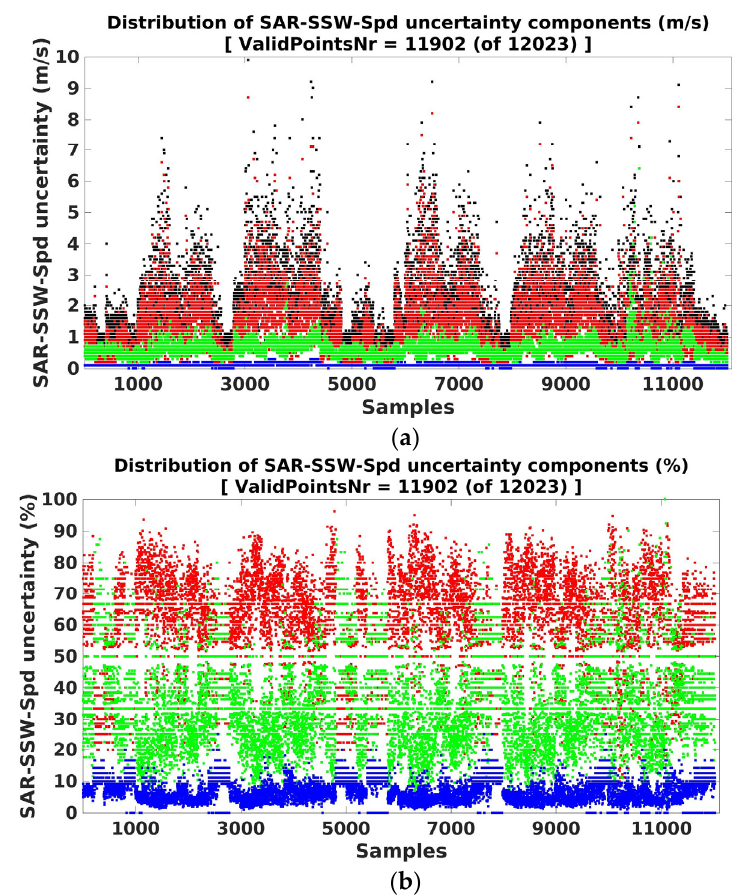
Figure 5. The total CMOD5.N-derived SAR SSW speed uncertainty ∆ W max (m/s) (purple), derived considering the three uncertainties ( ∆ σ 0 , ∆ θ , ∆ ϕ ) and the true state ( σ 0 , θ , ϕ ), and the contribution to this uncertainty due to the true state ( σ 0 , θ , ϕ ) and a single uncertainty among the ones regarding the NRCS ( ∆ σ 0 ) (green), the incidence angle ( ∆ θ ) (blue) and the MS LG-Mod SSW (relative) direction ( ∆ ϕ ) (red) ( a ). The corresponding ratio with reference to the total SSW speed uncertainty shown, in the range [0, 100] (%), with the same colours ( b ). Values are obtained for all the 5 km-ROIs. Figure 6 shows, as sample spatial distributions, the NRCS σ 0 (a), the incidence angle θ ( ◦ ) (c), the MS LG-Mod SSW direction ϕ ( ◦ ) (e), and the CMOD5.N-derived SSW speed W (m/s) (g), with their related uncertainties ∆ σ 0 (b), ∆ θ ( ◦ ) (d), ∆ ϕ ( ◦ ) (f) and ∆ W max (m/s) (h), respectively. All maps are obtained at 5 km by 5 km and refer to a 65 km by 65 km region in the Atlantic European northwest shelf, which was cropped from the VV- polarised, ascending, Sentinel-1 IW image acquired on 16th May 2018 at 17:33:28 UTC. Estimated SSW vectors are superimposed in each image of the figure. SSW directions derive from MS LG-Mod, while speeds are from the proposed methodology. SSW vectors are referred to the range-azimuth geometry using the true heading parameter of the S-1